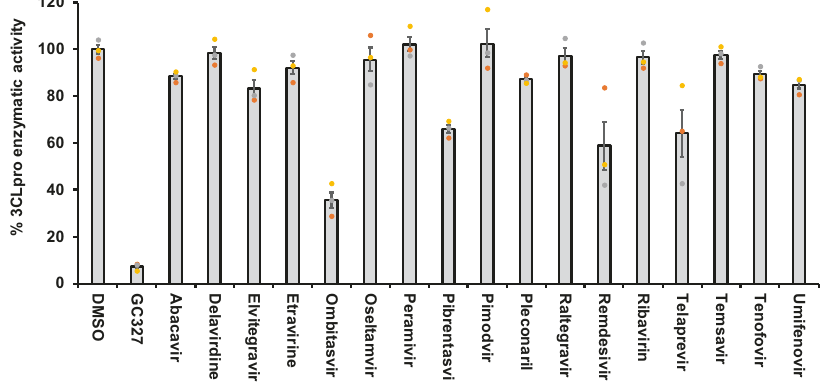
Fig. 3 Non protease inhibitor ombitasvir inhibited SARS-CoV-2 3CLpro activity partially. The non-protease anti-viral drugs selected by computational studies were screened for their inhibitory activity against SARS-CoV-2 3CLpro enzyme as described under Methods section. The percent enzymatic activity was calculated as described in Fig. 1 legend. Blank values were subtracted from all the readings before calculating the percent activity. Representative of three individual experiments with triplicate values were presented graphically ( n = 3). P value < 0.001 considered as statistically signi fi cant. One-way ANOVA with Dunnett ’ s Multiple Comparison post-hoc test used to calculate the statistical signi fi